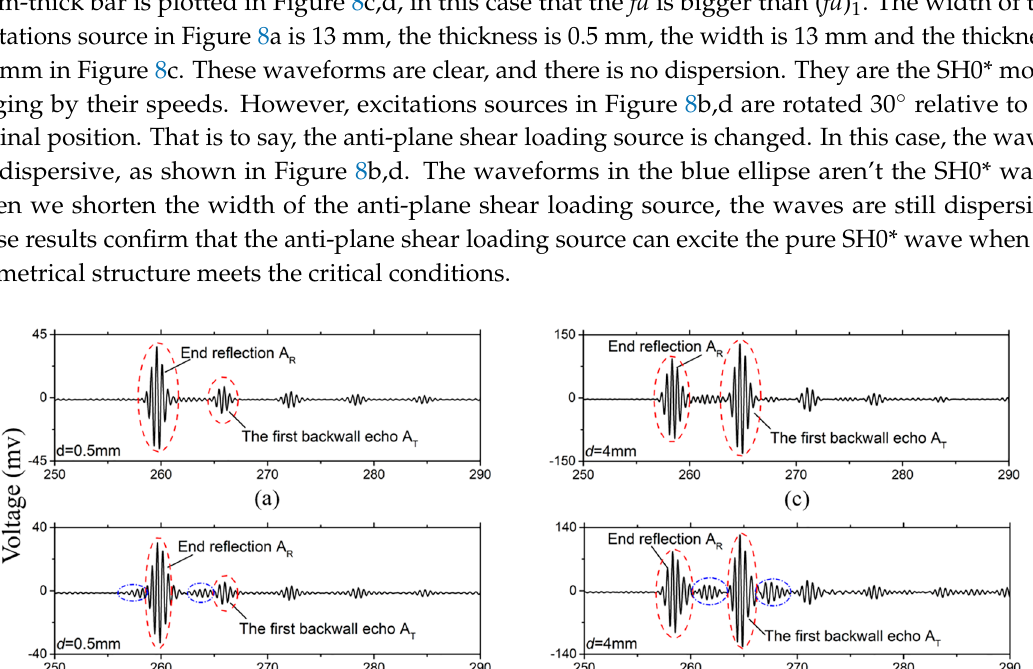
Figure 8. Waveforms of the time domain in some waveguide bars: ( a ) d = 0.5 mm, w =13 mm, the loading is anti-plane shear source; ( b ) d = 0.5 mm, w =13 mm, the loading isn’t anti-plane shear source; ; ( c ) d = 4 mm; w =13 mm; the loading is anti-plane shear source ( d ) d = 4 mm, w =13 mm, the loading isn’t anti-plane shear source. Curves of the transmission efficiency η versus thickness are shown in Figure 9. They monotonically increase. These curves shows that the thicker the waveguide is, the more energy of the SH0* wave is transferred into the test plate for damage detection. Moreover, the effect of temperature change on the transmission efficiency can be neglected.